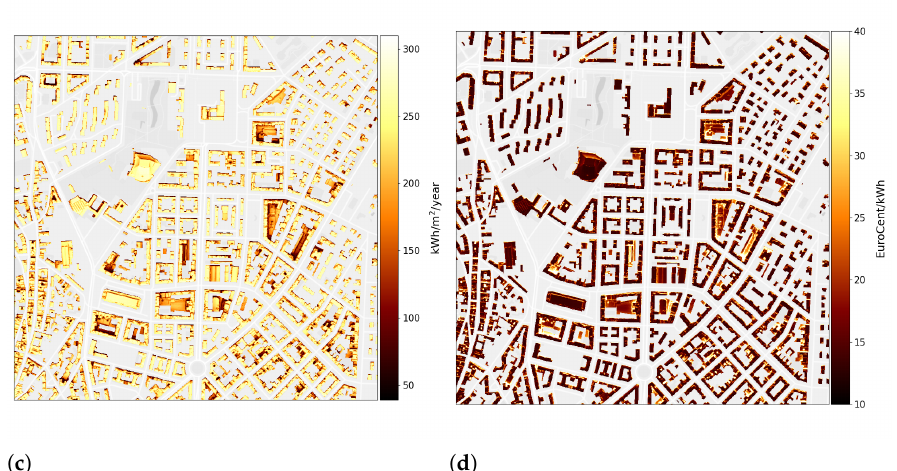
Figure 8. Maps showing, for the rooftop surfaces within the Municipality of Cagliari, ( a ) the yearly average values per m 2 of GHI, ( b ) irradiation on the POA, ( c ) and photovoltaic potential; ( d ) aver- age